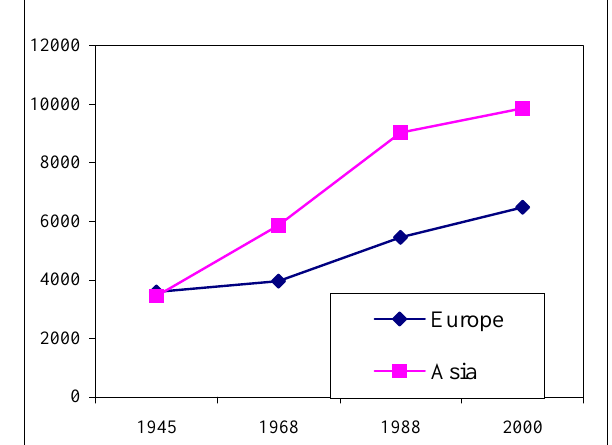
Figure 3: Grow of the different groups by linear time-scale and trend-graphs